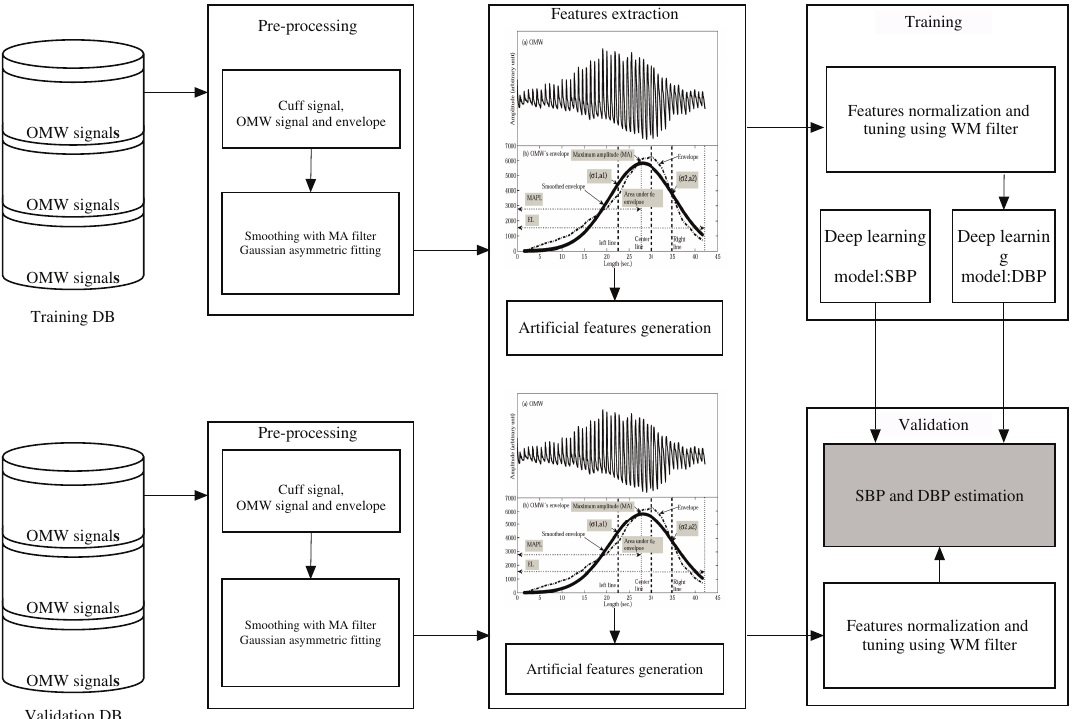
Figure 1. Flow chart of the proposed